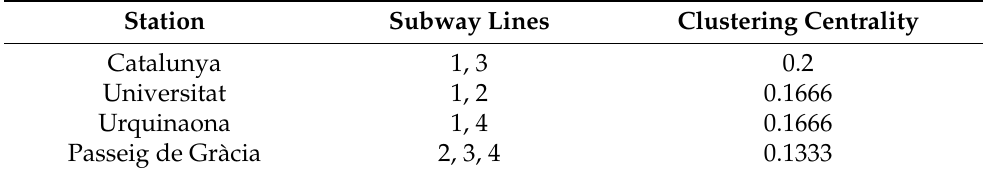
Table 4. Stations with non-zero clustering centrality.